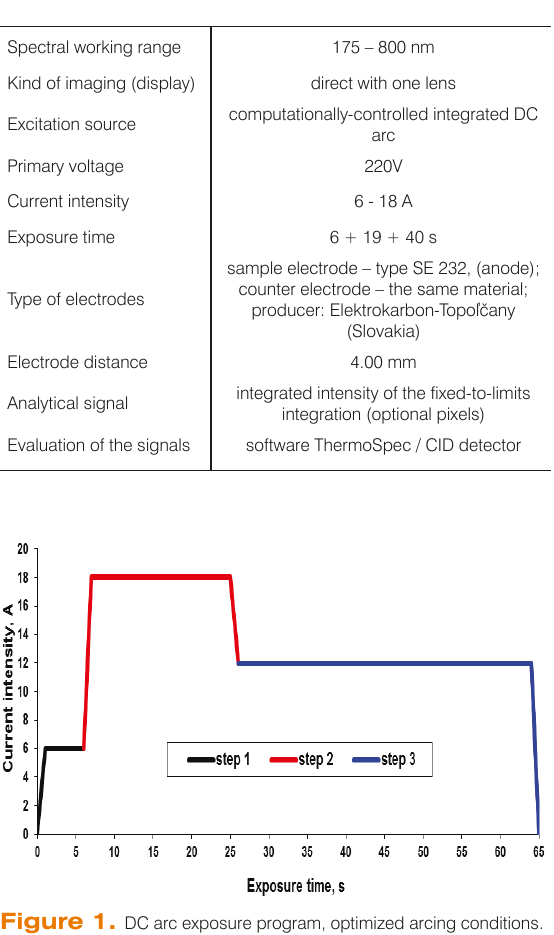
Table 1. Experimental conditions for the work with spectrometer Atomcomp 2000.